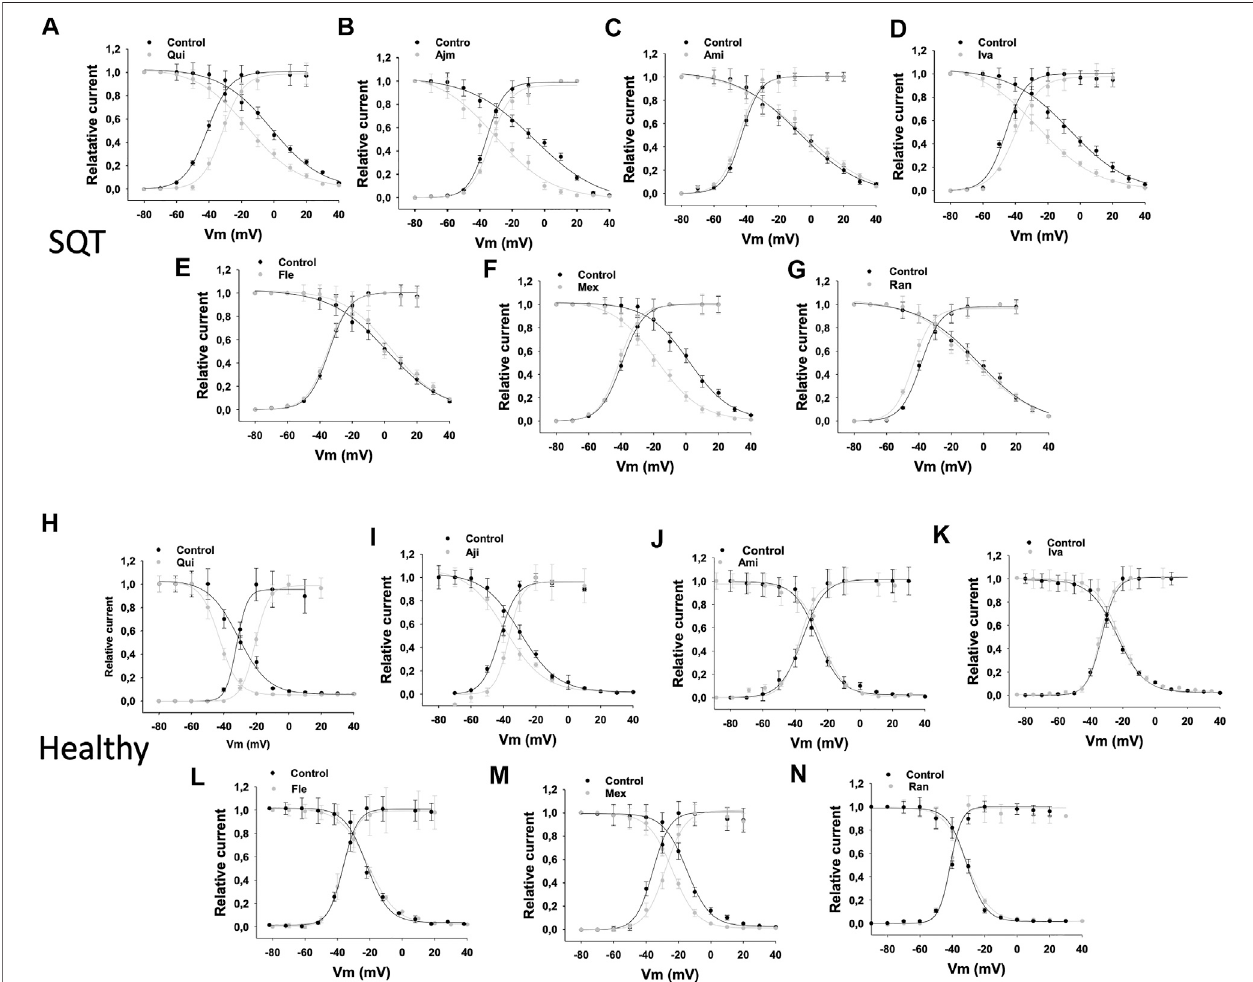
FIGURE 6 | Drug effects on window currents of I Kr in SQTS1-hiPSC-CMs. The activation and inactivation curves were plotted in the same fi gure. The window current was de fi ned as the current under the crossover of activation and inactivation curves. The activation curves are the same curves as in Figure 3 . To obtain the inactivation curves, a pulse of 1 s from − 80 to +60 mV was applied to activate and inactivate hERG channels. Then, the pulse was set to − 100 mV for 20 ms to let the inactivatedchannelsrecovertoopenstate.Beforethedeactivationoccurs,atestpulseto+60 mVfor500 mswasappliedandthepeakcurrentatthetestpotential was measured. The voltage of recovery pulses was changed from − 100 to +80 mV. The currents at test pulse versus respective voltages of the recovery pulses were normalized to the maximal current and plotted against voltages of the recovery pulses to obtain the inactivation curves (availability-voltage curves). The cell numbers of activation curves are same as that in Figure 3 . The cells numbers of inactivation curves are nine for each drug experiments. For comparison, the window currents in absence (black points and lines) and presence (grey points and lines) of drugs were overlapped in the same plot. (A – G) Overlapped activation and inactivation curves showing the widow currents in SQT1-hiPSC-CMs in absence (Ctr) and presence of quinidine (Qui, 10 µM), ajmaline (Ajm, 30 µM), amiodarone (Ami, 10 µM), ivabradine (Iva, 10 µM), fl ecainide (Fle, 30 µM), mexiletine (Mex, 100 µM) and ranolazine (Ran, 30 µM). (H – N) Overlapped activation and inactivation curves showing the widow currents in donor-hiPSC-CMs in absence (Ctr) and presence of each